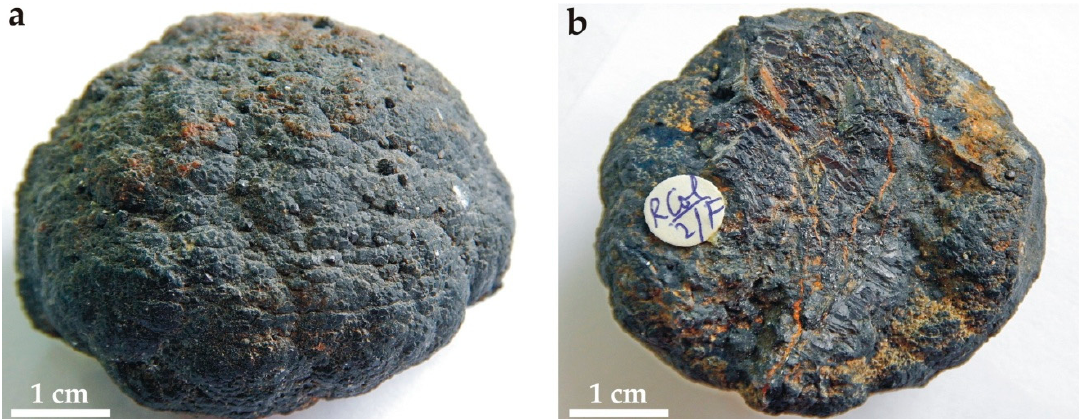
Figure 7. ( a ) Attached single black calcite sphere from Herja (sample RCol / 2 / F, MMBBU); ( b ) Cross-section through the base of the sphere that corresponds to the connection to the substratum, with no clear, well-developed inner crystal like that in Figure 6f; however, the black calcite contains abundant needle-like jamesonite crystals. Note the late siderite deposition along the fissures.